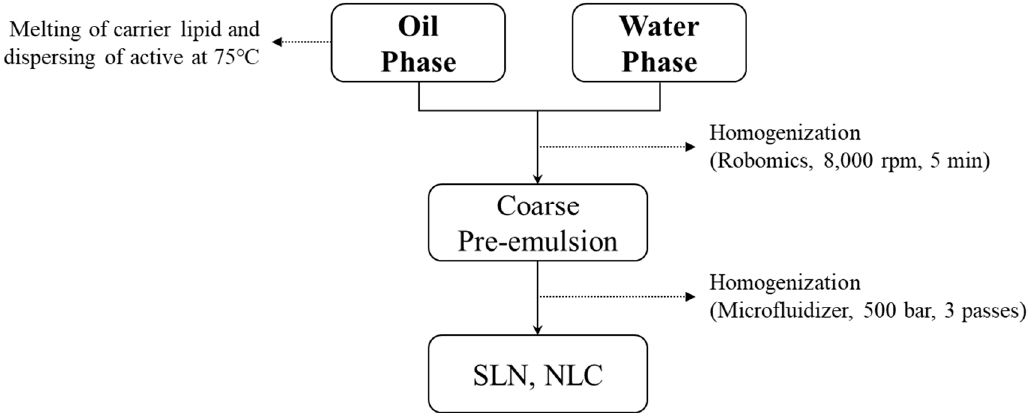
Figure 1. The solid lipid nanoparticle (SLN) and nanostructured lipid carrier (NLC) manufacturing processes.